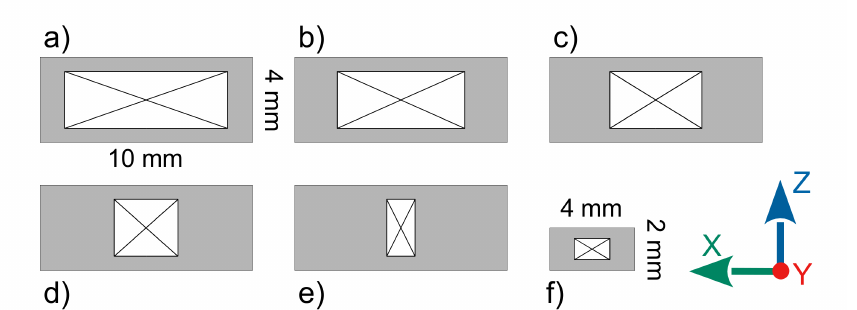
Figure 5. Cross sections of samples: ( a ) type 1A, 3 layers of contour, ( b ) type 1A, 5 layers of contour, ( c ) type 1A, 7 layers of contour, ( d ) type 1A, 9 layers of contour, ( e ) type 1A, 11 layers of contour, ( f ) type 5A, 3 layers of